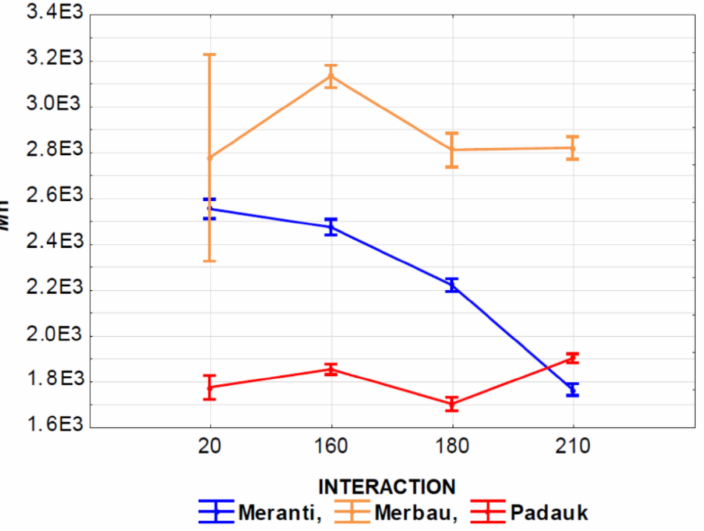
Figure 7. The effect of thermal modification temperature and wood species on number average molecular weight ( M n ) values.